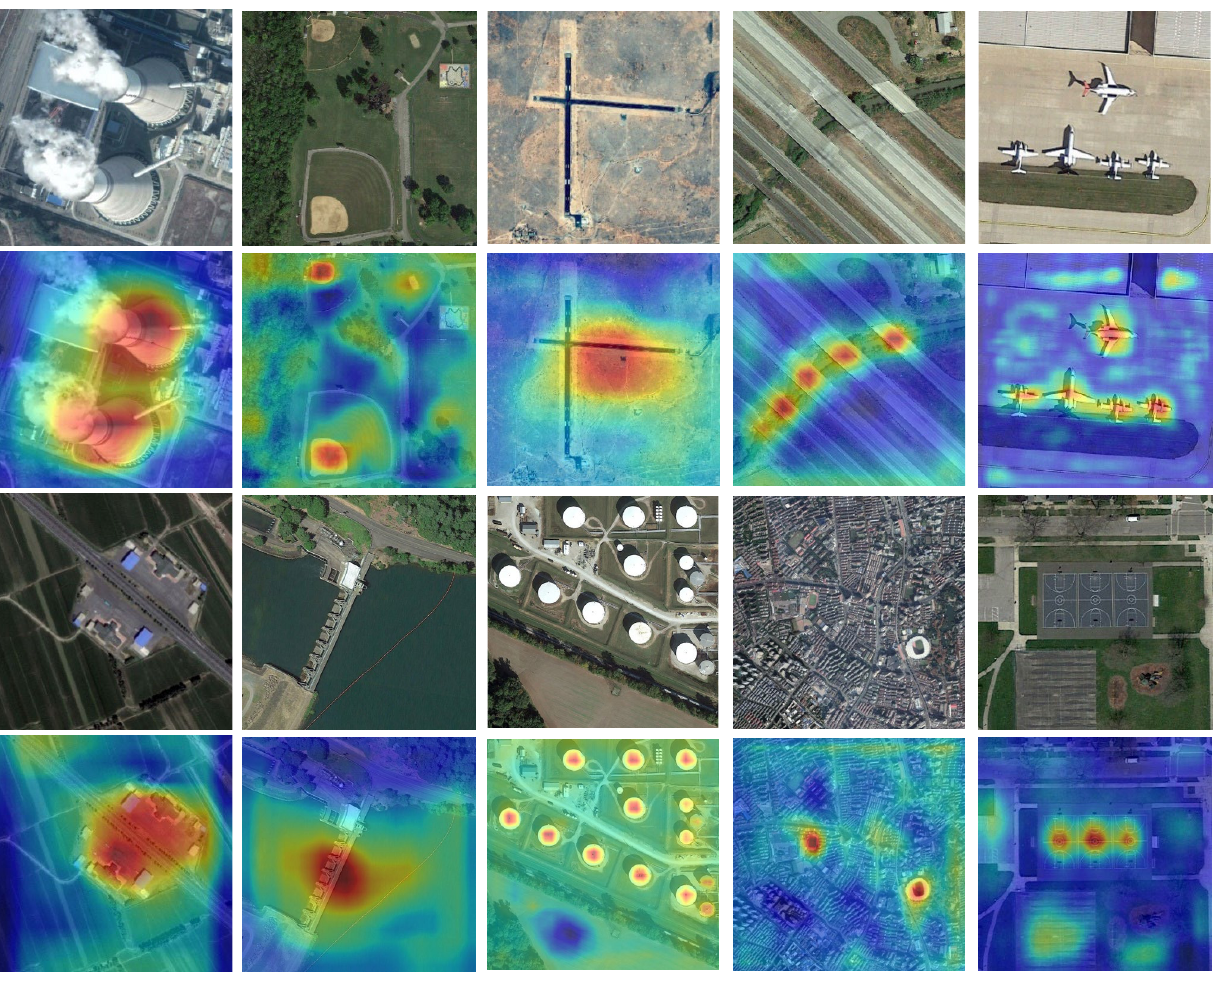
Figure 11. Visualization of typical object